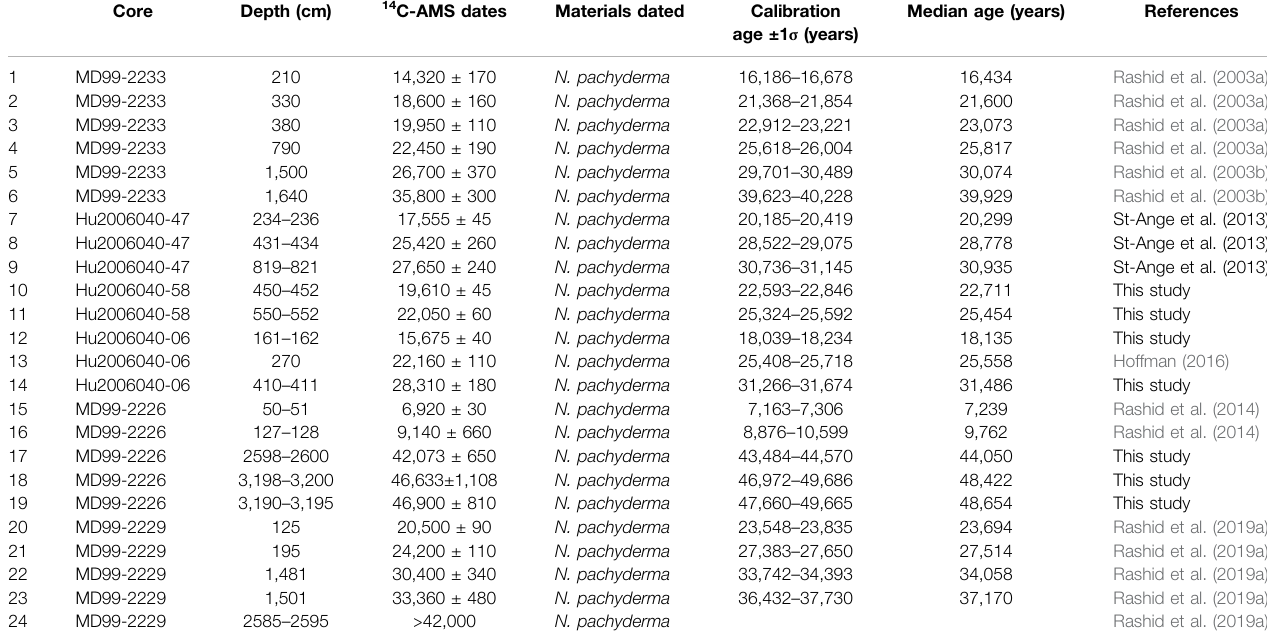
TABLE 1 | 14 C-AMS dates used in the study.